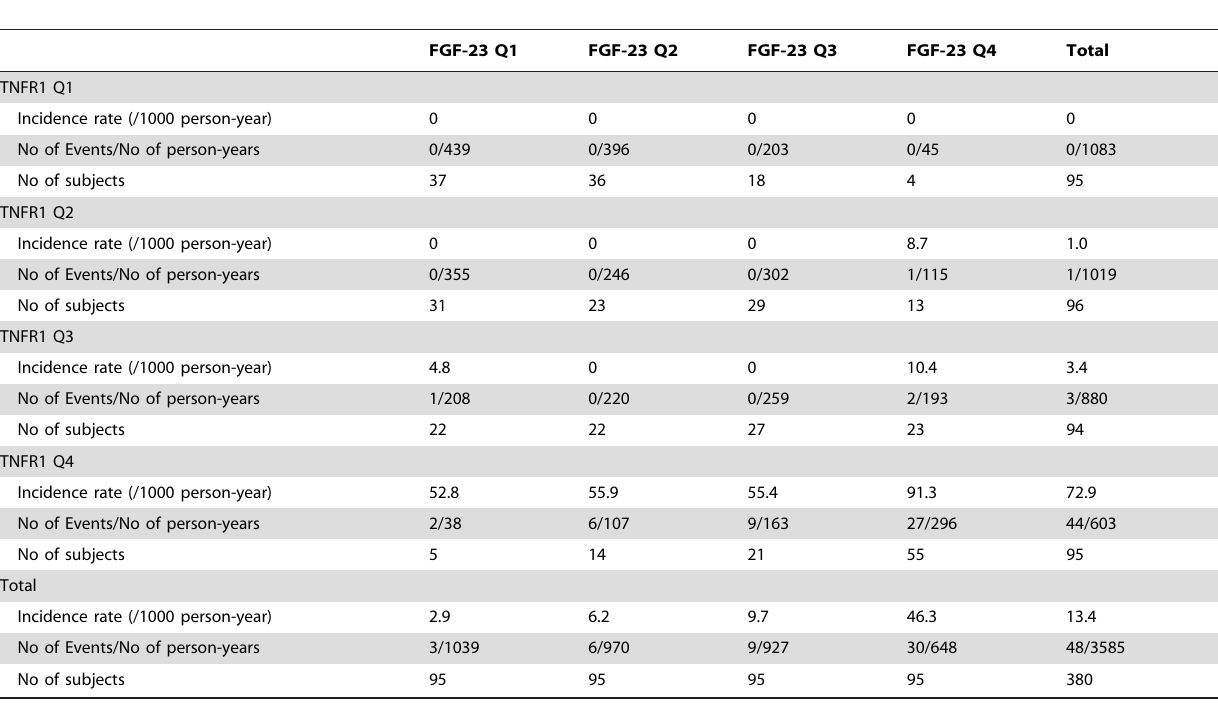
Table 2. Incidence rate of ESRD in subjects with T2D stratified by quartiles of FGF-23 and TNFR1.